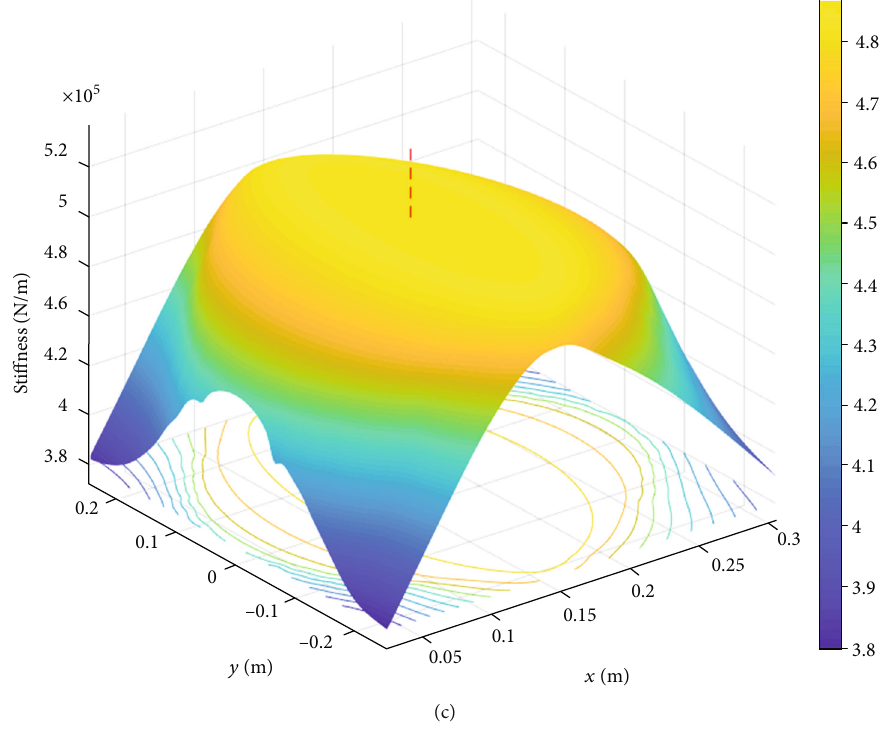
Figure 5: The sti ff ness in di ff erent con fi